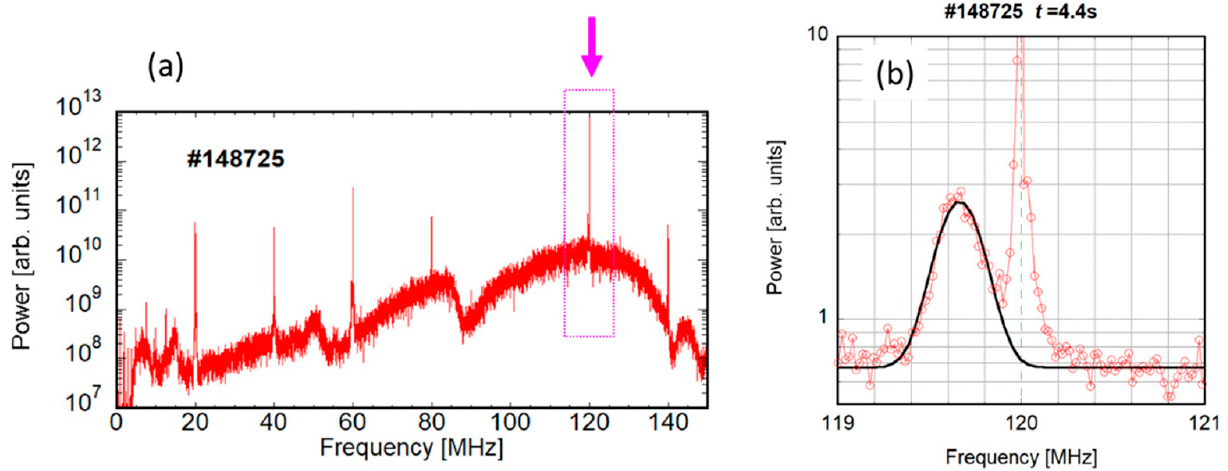
Figure 11. Frequency spectra of ( a ) entire scattered signal from LHD plasma (shot number is #147825). and ( b ) magnified view of 120 MHz IF frequency component (the area enclosed by the dotted square in ( a )). (monitor point 6).